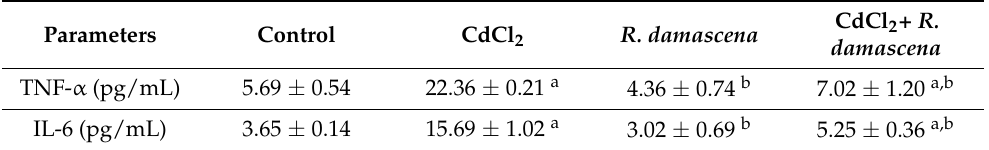
Table 7. R. damascena leaves extract dose (100 mg Kg − 1 ) ameliorated serum TNF- α and IL-6 in CdCl 2 (5 mg Kg − 1 ) groups. Data are expressed as mean ±